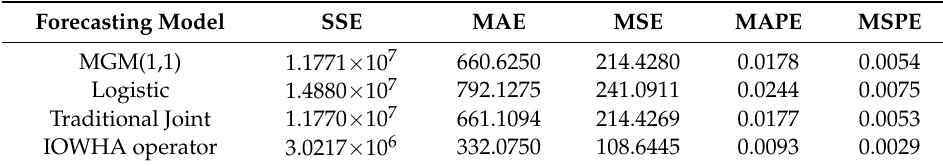
Table 6. Forecasting result estimation of China’s electricity